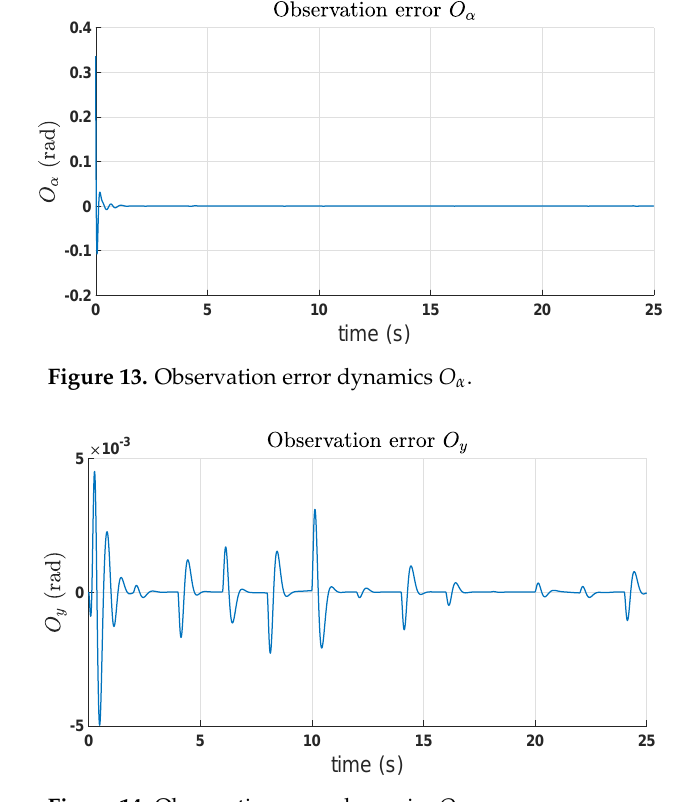
Figure 14. Observation error dynamics O y